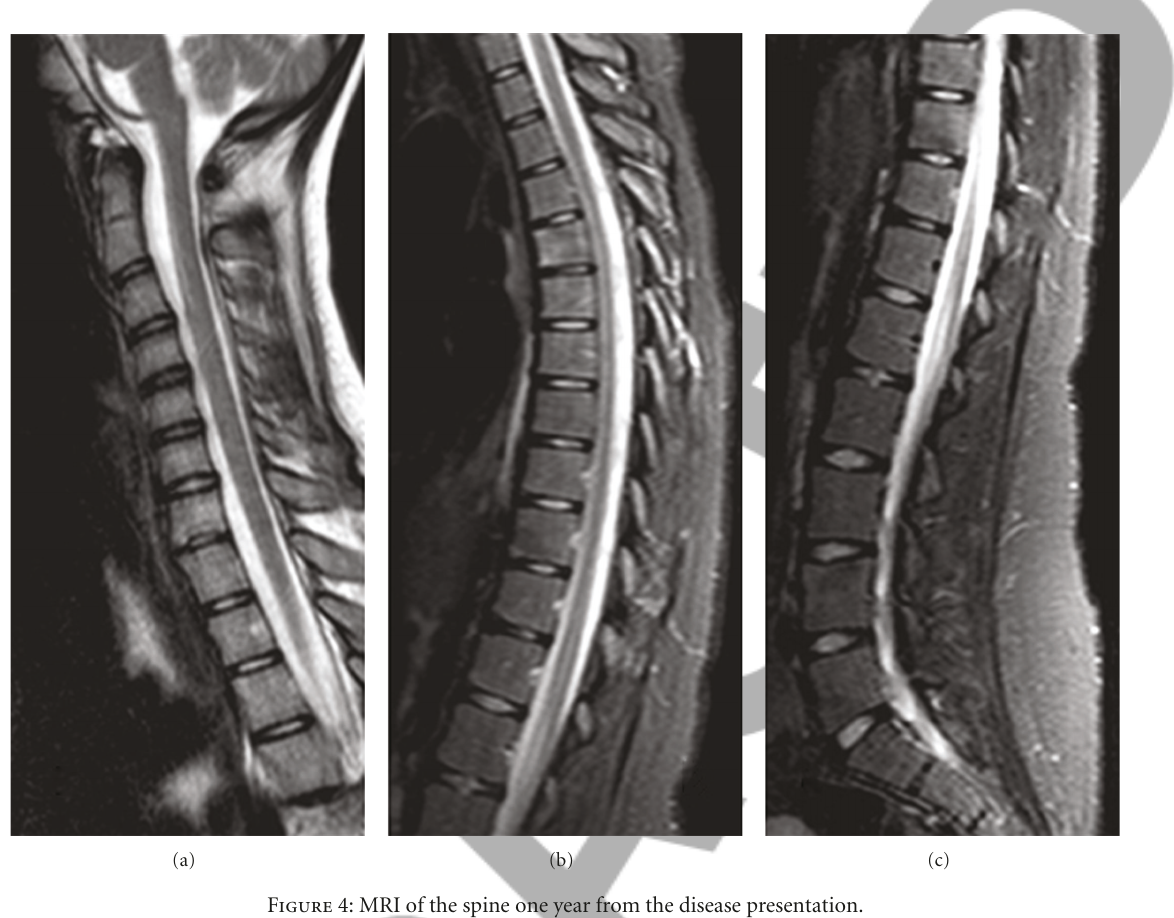
Figure 4: MRI of the spine one year from the disease